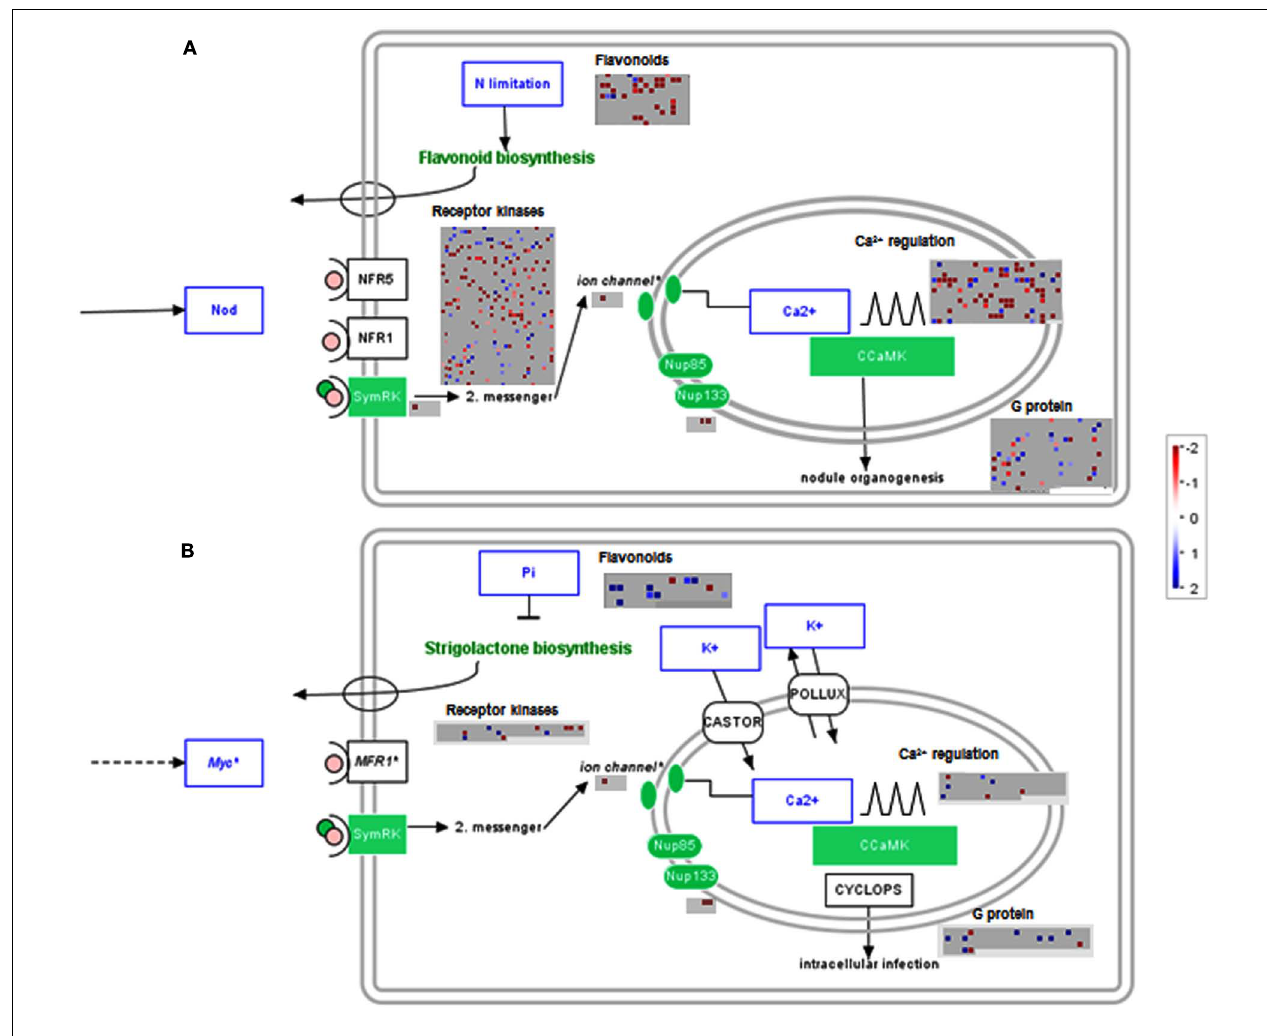
(RMA) in R, and classed according to the MAPMAN classifications (Thimm et al., 2004; Usadel et al., 2005) adapted for lotus (Sanchez et al., 2008) and tomato (Urbanczyk-Wochniak et al., 2006), respectively. Red indicates a decrease whereas blue indicates an increase (see color